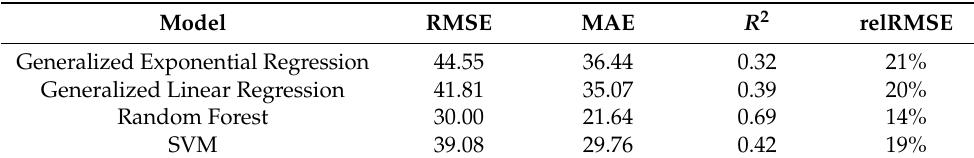
Table 4. Statistical indicators of modelled data versus observed AGB.